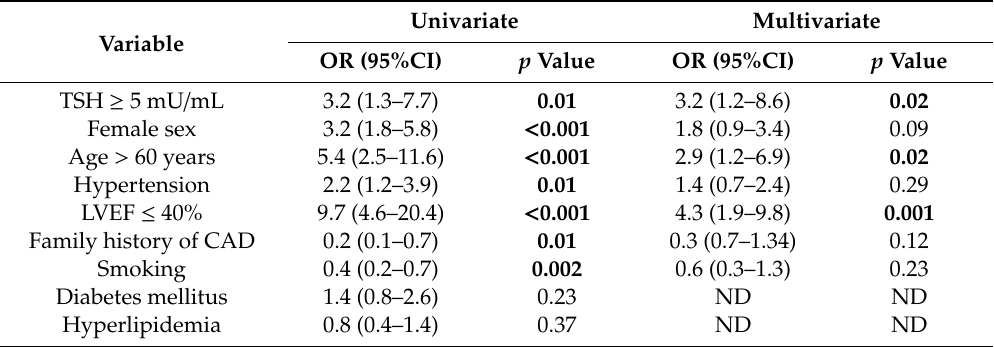
Table 3. Univariate and multivariate binary logistic regression model for 30-day mortality according to the presence of subclinical hypothyroidism.